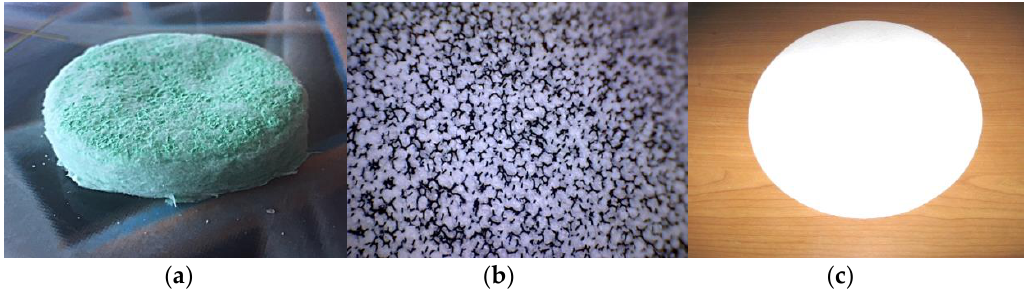
Figure 17. A cake prepared by suctioning an aqueous slurry of porous SiO 2 nanofibers ( a ), open PU foam filled with powder prepared from porous SiO 2 nanofibers by grinding in an agate bowl ( b ), and a thin layer made of a mixture of nanofibers and scanned microfibers with paper-making technology ( c ).